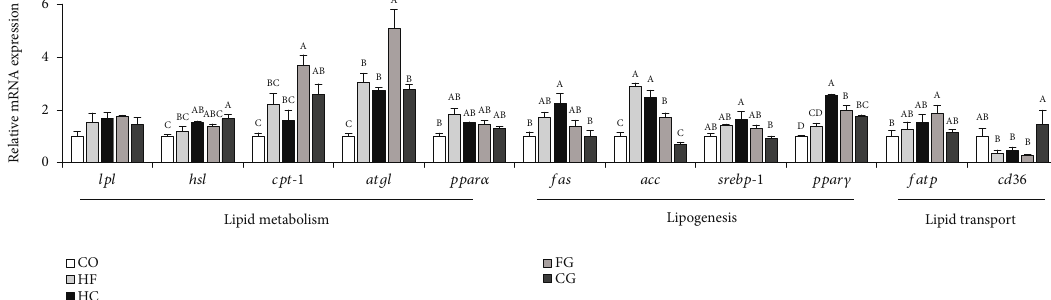
Figure 4: Expressions of the genes related to lipid metabolism in the liver of common carp fed di ff erent experimental diets. Values are means ± S : E : per diet in triplicate tanks ( n = 6 ). The di ff erent letters indicate the di ff erences between diets (one-way ANOVA, Duncan ’ s test, P < 0 : 05